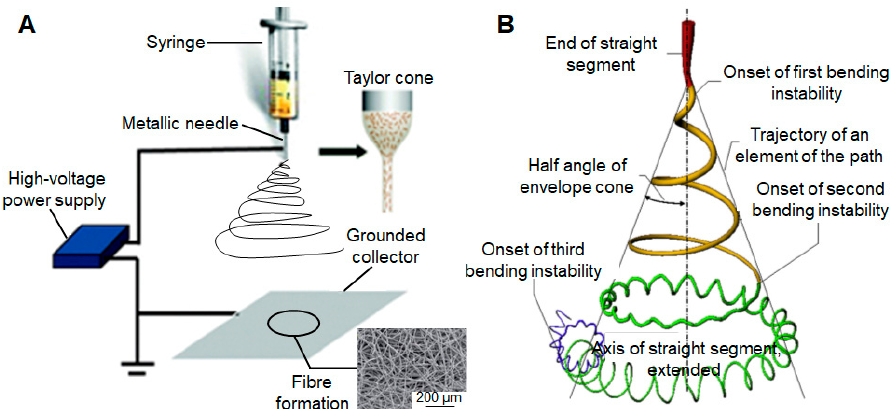
Figure 2. The primary electrospinning apparatus and mechanism. ( A ) Schematic illustration of the typical electrospinning set-up; reproduced from [38] with permission from the Royal Society of Chemistry, Copyright 2014; ( B ) A diagram that shows the prototypical instantaneous position of the path of an electrospinning jet that contained three successive electrical bending instabilities; reproduced from [39] with permission from Elsevier Ltd, Copyright 2008.